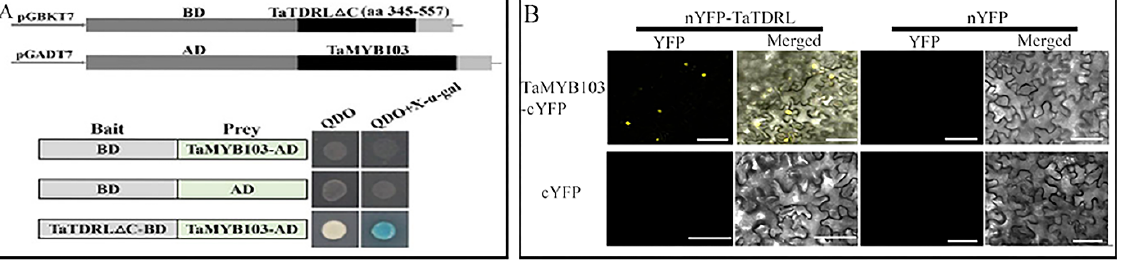
Figure 3. The interaction between TaTDRL with TaMYB103. ( A ) Yeast two-hybrid assay to test the interaction of TaTDRL with TaMYB103. QDO, SD/ − Trp/ − Leu/ − His/ − Ade medium. ( B ) Bimolecular fluorescence complementation (BiFC) assay for confirmation of the interaction between TaTDRL and TaMYB103. Scale bars: 50 µm in ( B ).